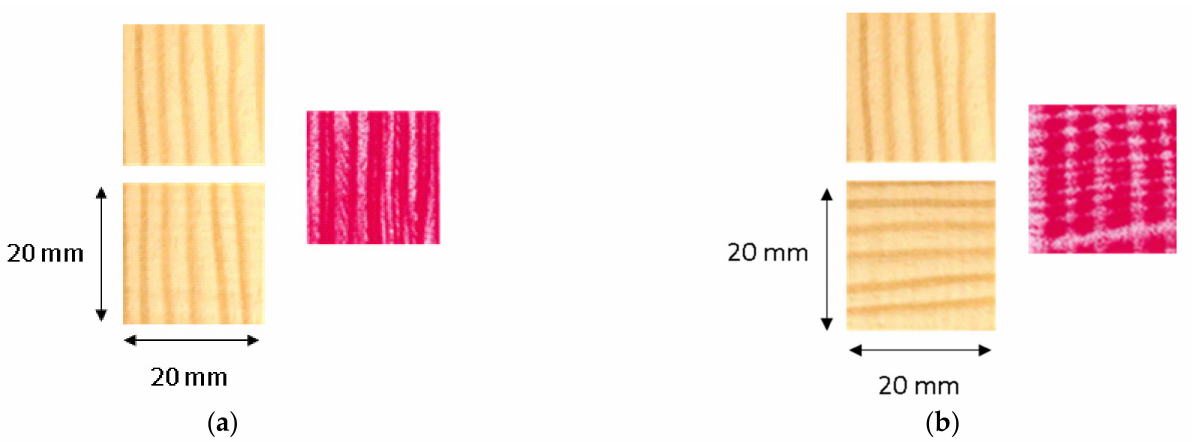
Figure 13. Formation of characteristic patterns when compressing pine veneer rectangles with a 0 ◦ ( a ) and 0/90 ◦ layer angle difference ( b